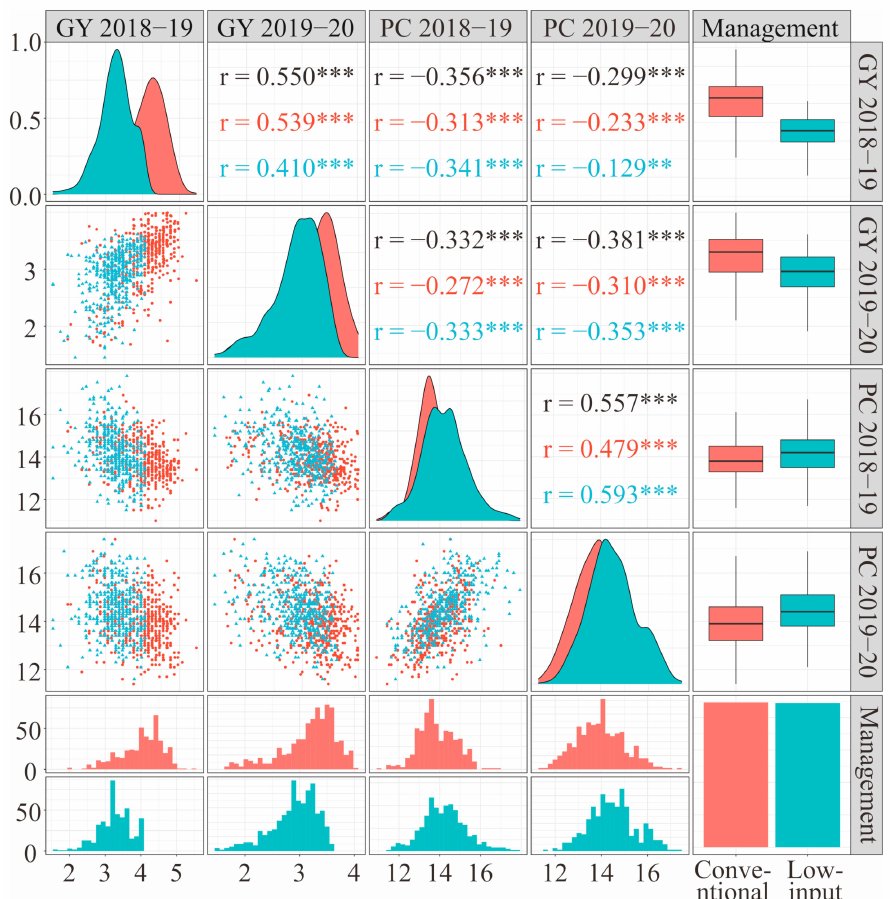
Figure 3. The distribution of the grain yield (GY) and protein content (PC) of different wheat genotypes of wheat in different growing seasons and under different management conditions, and the relationships between them. The r represents the correlation coefficient, and the color of its value is consistent with the plots in the figure. Significance level: ***, p < 0.001; **, p <